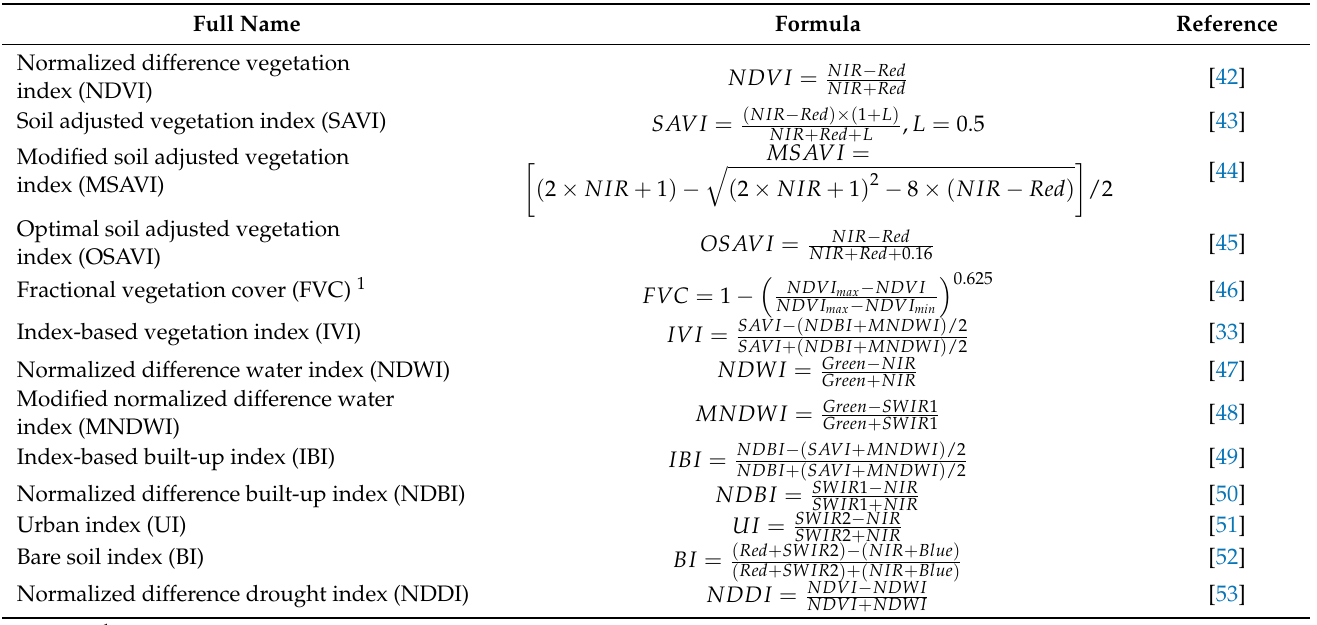
Table 3. Information on the common spectral